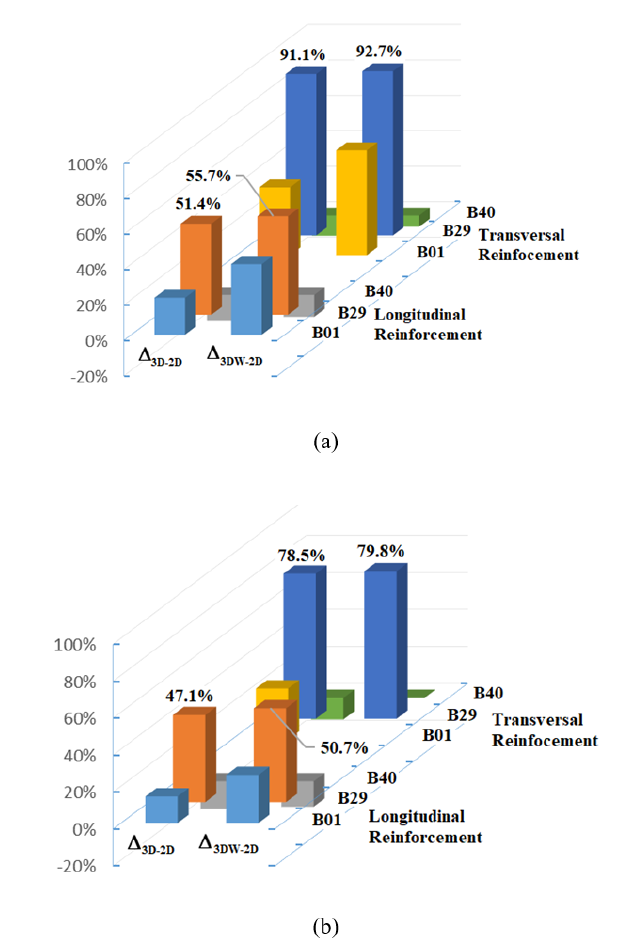
Figure 18. Differences between design results according to the analysis models: (a) Non-eccentric loading and (b) Eccentric loading.